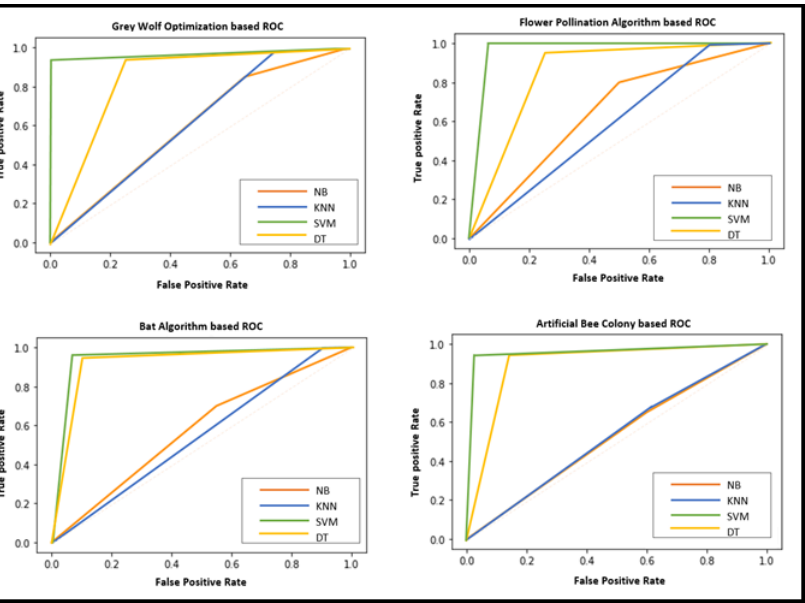
Figure 8. ROC curves of the proposed models on the PBC dataset.